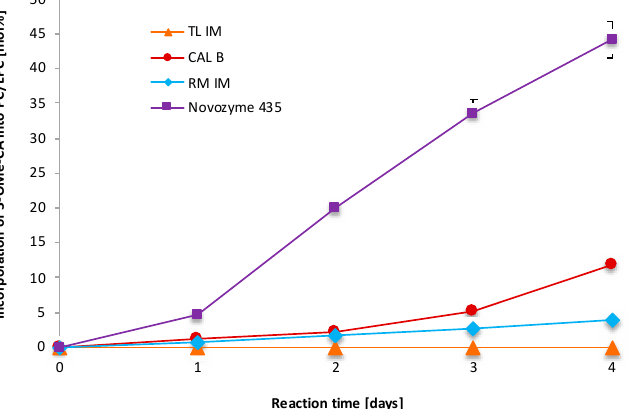
Figure 1. Dependence of incorporation degree of 3-OMe-CA into egg-yolk PC on reaction time for different lipases (reaction conditions: 1:5 PC/3-OMe-CA molar ratio, solvent: heptane 2 mL, enzyme load 30% ( w / w ), temperature 50 °C). Vertical bars represent SD, n = 3.